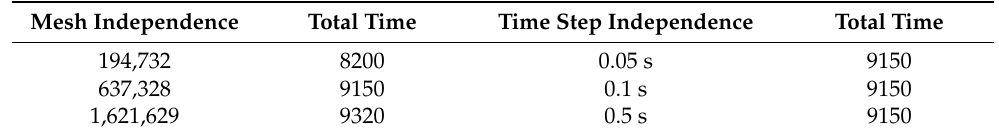
Table 1. Parameters of simulation for the MHSS.